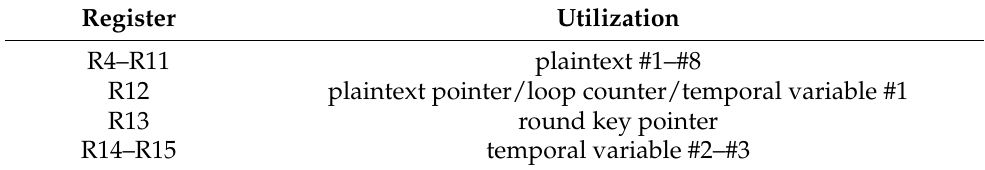
Table 3. Register utilization for ARIA encryption on the 16-bit MSP430